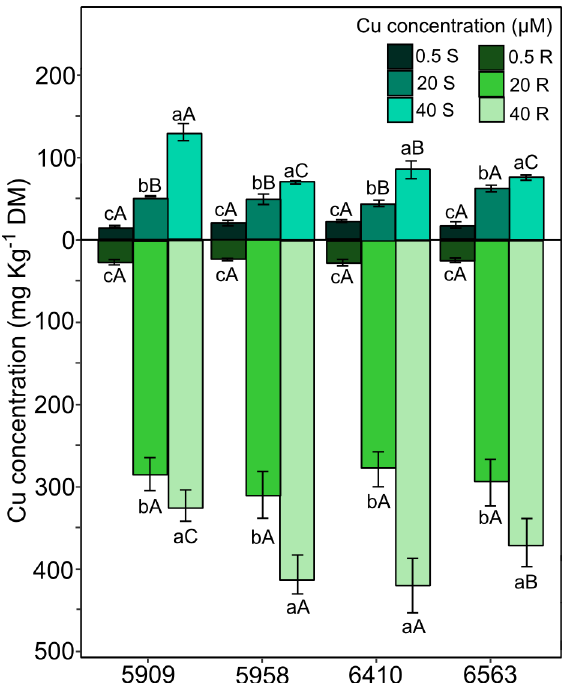
Figure 1 - Cu concentration in the shoots (S) and roots (R) of four soybean cultivars (5909, 5958, 6410 and 6563) grown in nutrient solution at three Cu concentrations (0.5, 20 and 40 μM ). Capital letters indicate comparison between cultivars in the same Cu concentration and plant part. Lowercase letters indicate comparisons between Cu concentrations in the same cultivar and plant part (p <0.05). Vertical bars represent ± standard